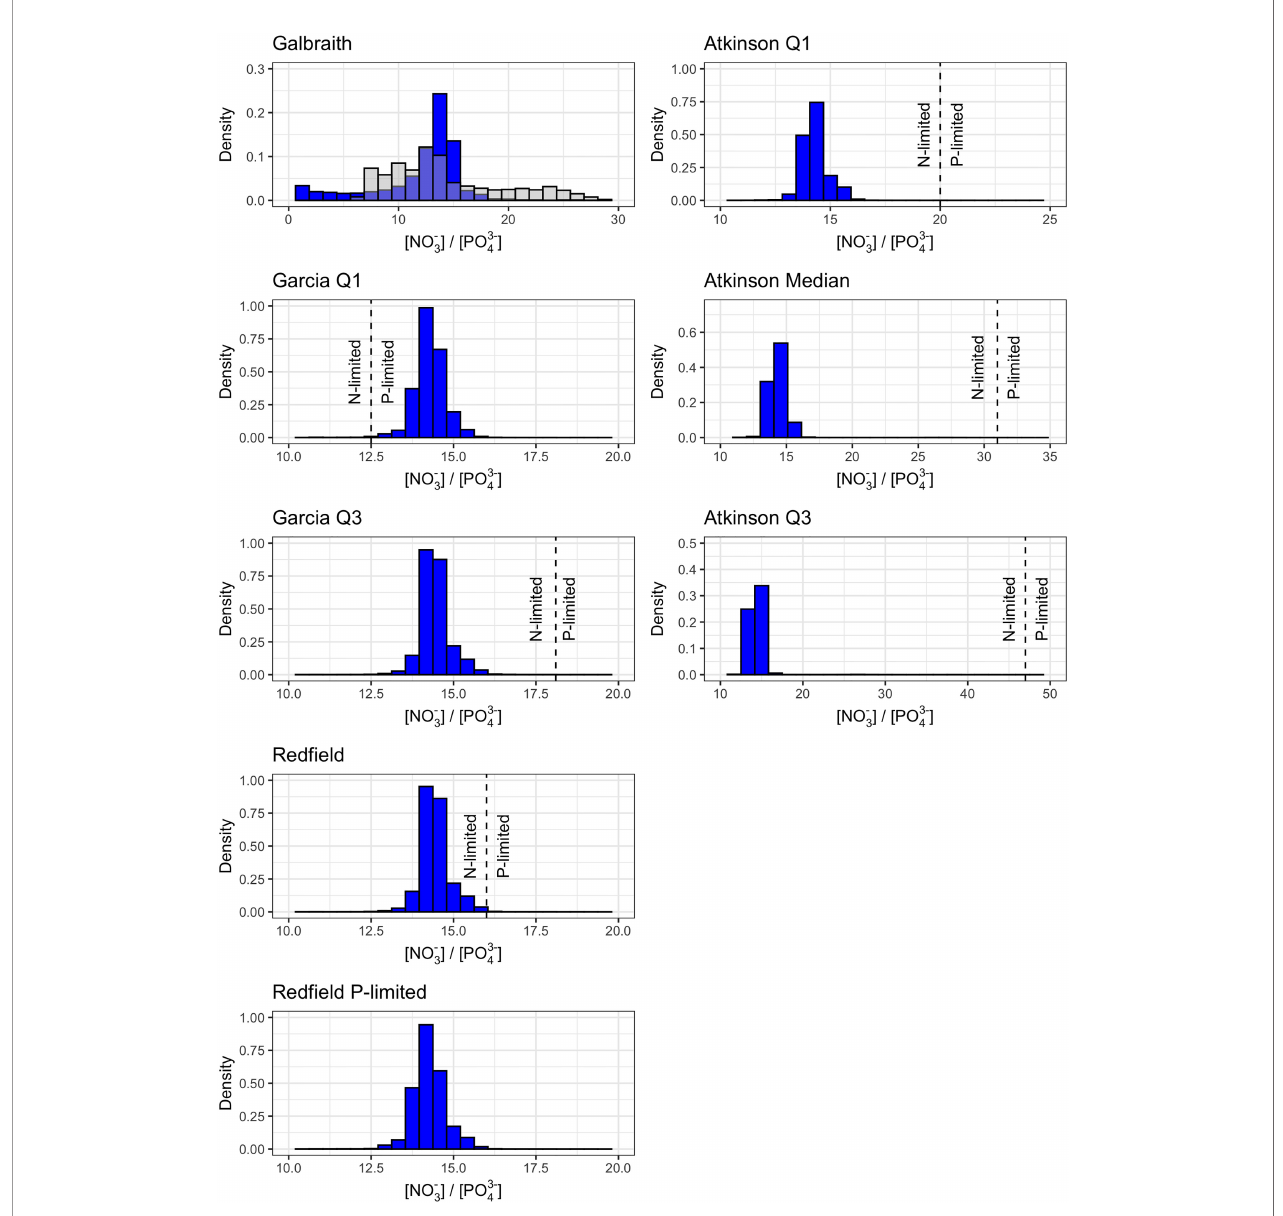
FIGURE 5 | Density histograms of the nitrate-to-phosphate ratio corresponding to maximum carbon dioxide removal potential shown in Figure S1 for microlage (left column) and macroalgae (right column) stoichiometries. Dashed lines show the nitrogen-to-phosphorus stoichiometry of the microalgae or macroalgae ( Table 1 ). Values to the left of the dashed line are nitrogen-limited and values to the right of the dashed line are phosphate-limited. The nitrogen-to-phosphorus stoichiometry of the Galbraith model are shown as the grey overlaying histogram. The nitrogen-to-phosphorus stoichiometry of the Red fi eld P-limited model is not shown because biogeochemical uptake is limited by phosphate availability only. Axis limits are adjusted between plots to facilitate visualization of the density histograms and their relationship to the nitrogen-to-phosphorus